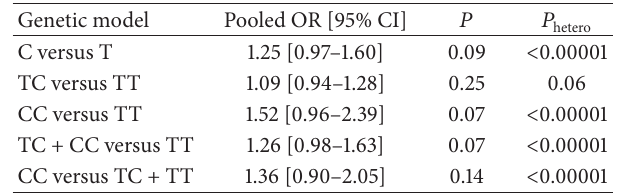
Table 3: Summary of pooled ORs in meta-analyses of rs2910164. Table 4: Summary of pooled ORs in meta-analyses of